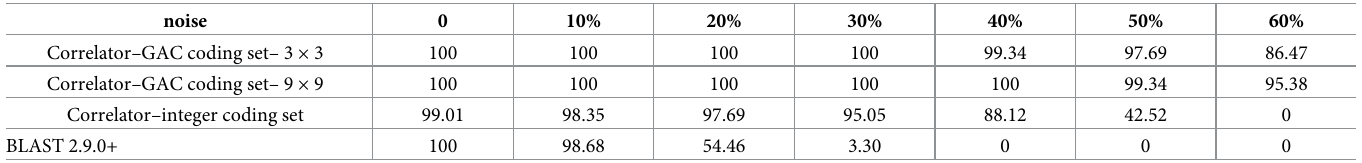
Table 6. Sensitivity (%) of three methods.